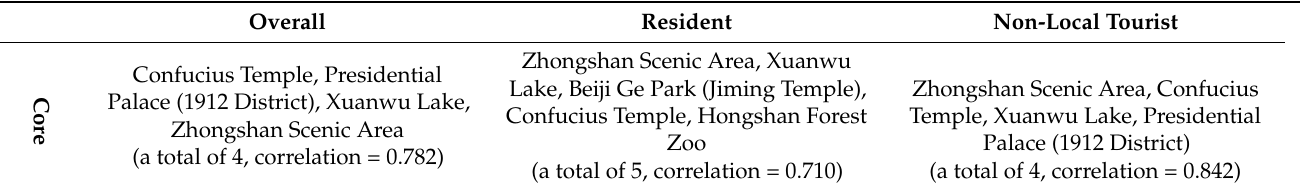
Table 5. “Core-edge” model under three types of network context (overall, resident, and non-local